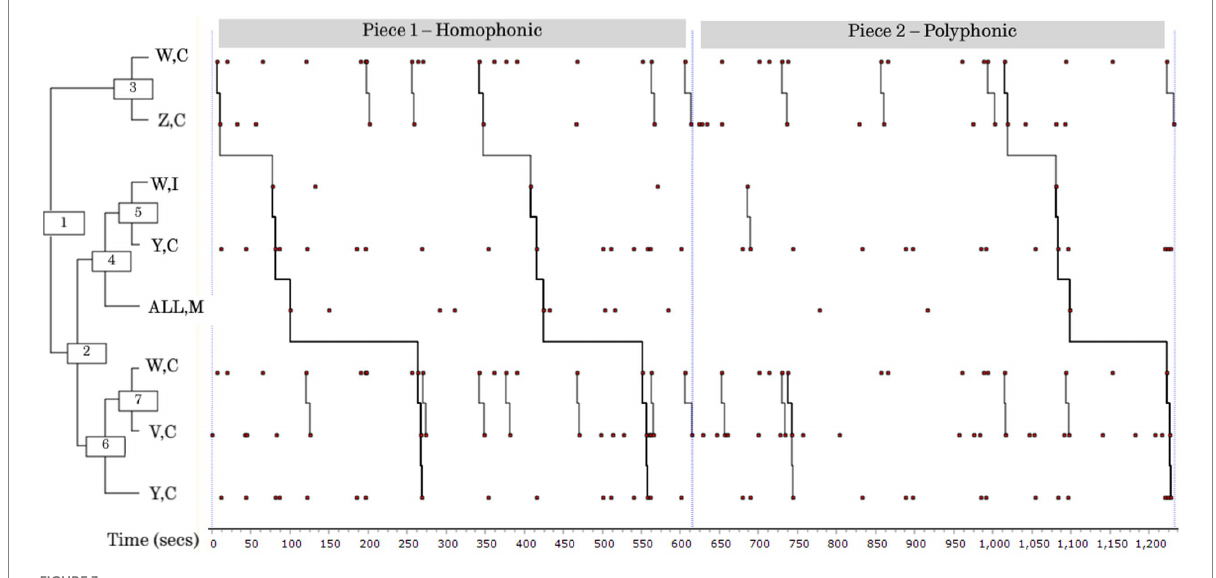
FIGURE 3 Pattern diagram (dendrogram) from THEME ® showing main patterns and frequent sub patterns (Group 2, Rehearsal 4). This pattern involves change of piece and shows persistence of sub patterns. The whole pattern ran as follows: first Singer W and Singer Z engaged in Clarifying behaviour (3). Singer W then Initiated, and Singer Y Clarified, after which All sang a passage (4). Singers W and V Clarified (7) and, finally, Singer Y Clarified (6). There were a large number of dyadic sub patterns (30 in total) distributed across the session, all featuring Singer W (3, 5, 7).